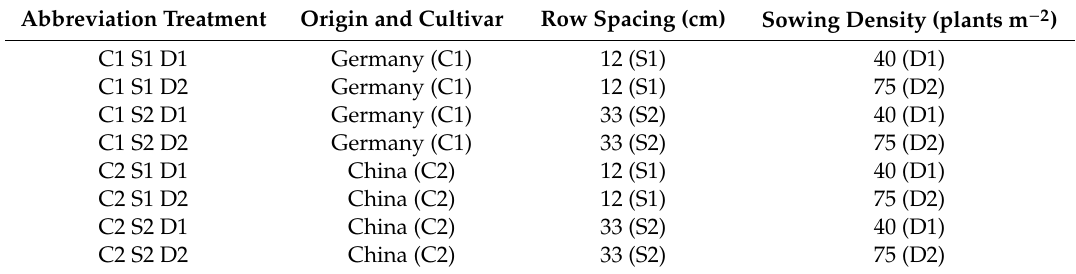
Table 1. Experimental treatments and abbreviations: two cultivars (C1 = German, C2 = Chinese cultivar), two row spacings (S1 = 12 cm, S2 = 33 cm), and two sowing densities (D1 = 40, D2 = 75 plants m − 2 ).